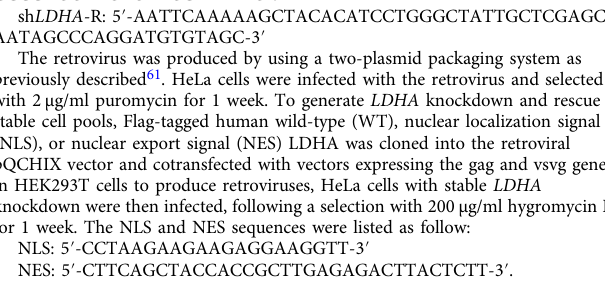
Fig. 6 Nuclear LDHA produced α -HB protects cervical cancer cells from oxidative stress. a , b Nuclear LDHA promotes cell growth under oxidative